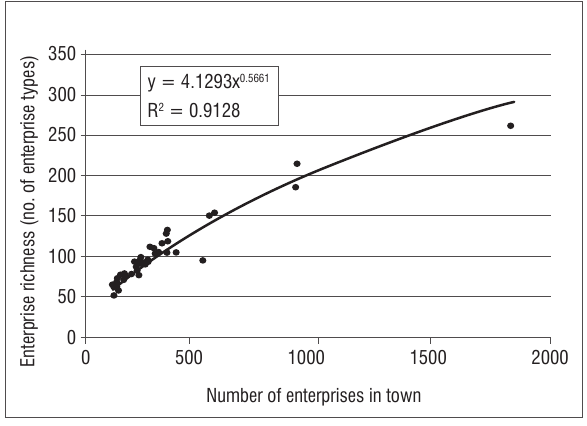
Figure 3: Enterprise richness as a function of the total enterprise numbers of 46 larger (>115 enterprises per town) South African towns.